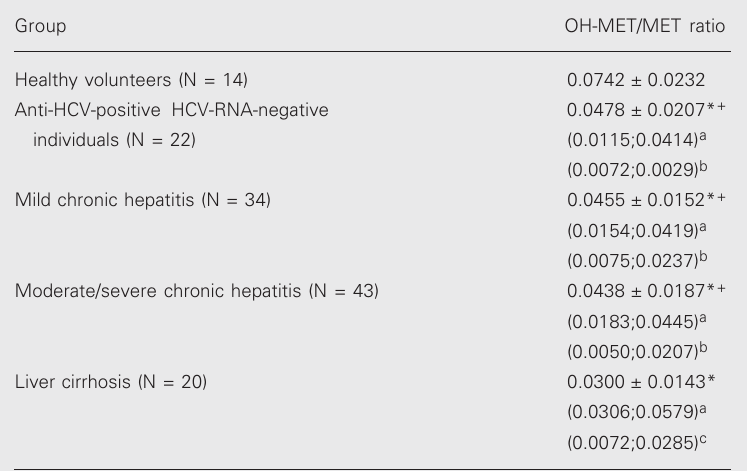
Table 1. Plasma hydroxy-metronidazole/metronidazole ratios 10 min after intravenous